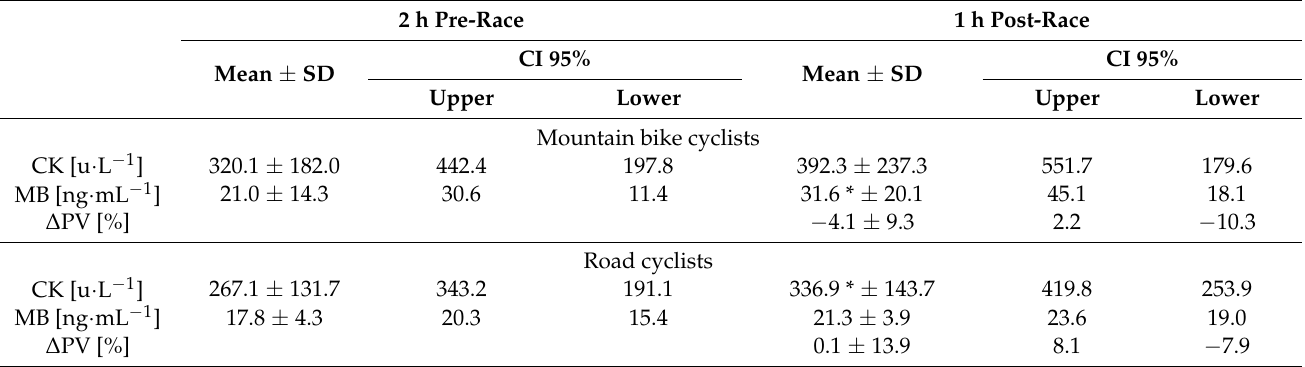
Table 3. Pre- and post-race CK activity and MB concentration and blood plasma volume. 2 h Pre-Race 1 h Post-Race